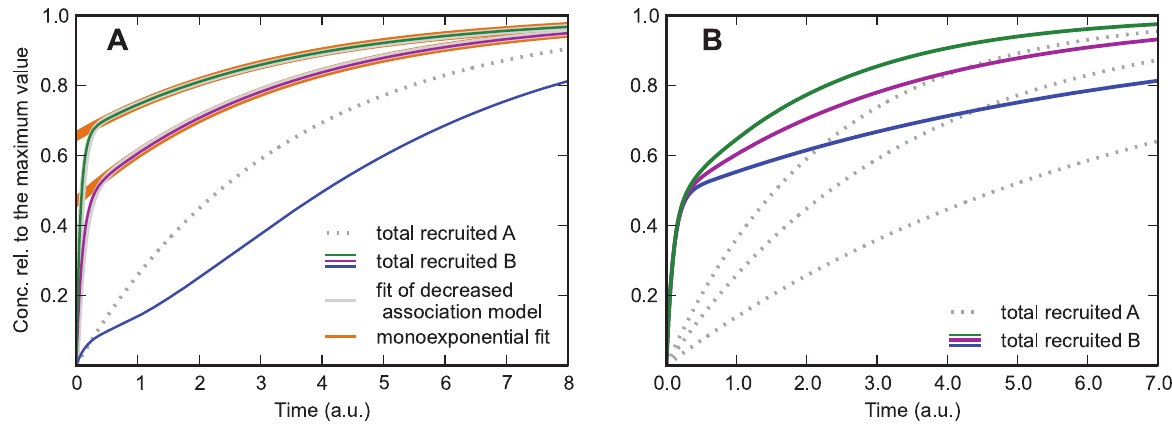
~ k (cid:3) ~ 0 : 3 , k (cid:3) ~ 0 : 5,5,10 from bottom to S z A SB z A S z B